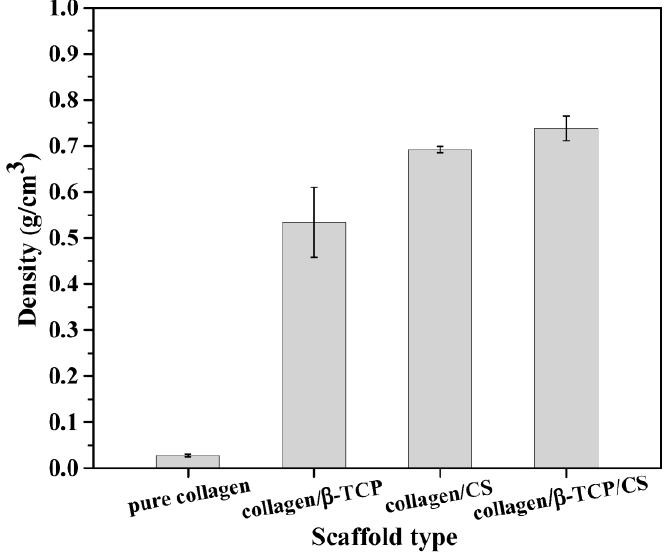
Figure 4. The densities of pure collagen scaffold and collagen/ β -TCP, collagen/CS, and collagen/ β - TCP/CS composite scaffolds.